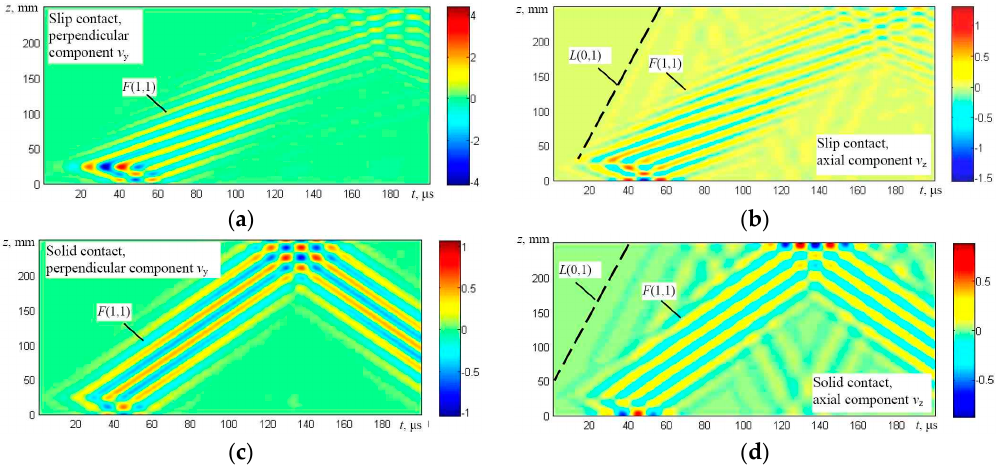
Figure 9. The B-scan images of the particle velocity along the first line of monitoring (the upper surface of the first wire) in the case of excitation from the top: particle velocity components v y perpendicular to the axis of the wire ( a ) and v z (longitudinal-axial) ( b ) in the case of slip contact and particle velocity components v y perpendicular to the axis of the wire ( c ) and v z (longitudinal-axial) ( d ) in the case of a solid contact between the neighboring wires.